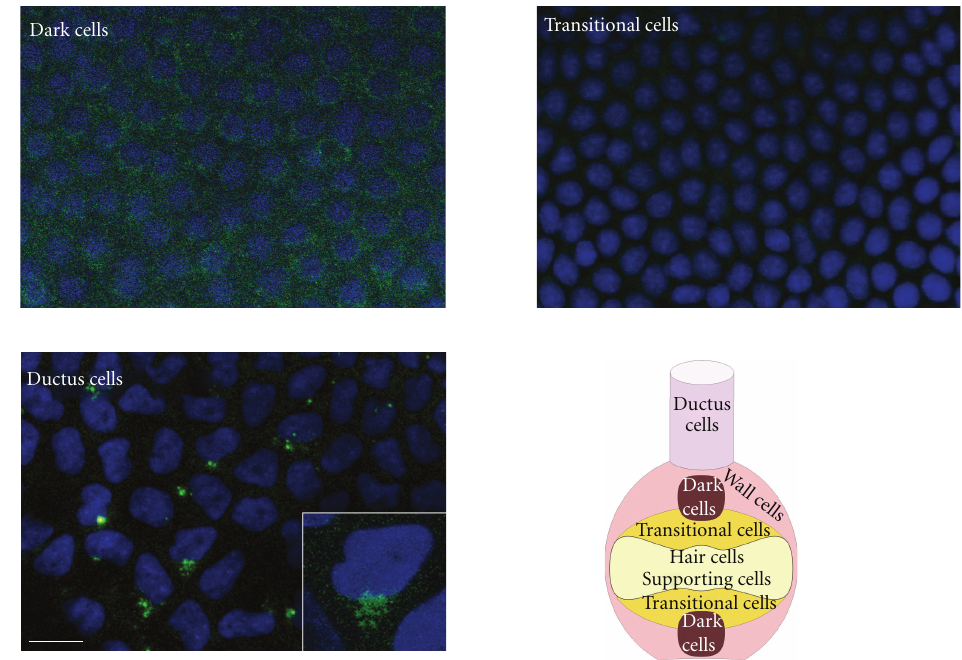
Figure 4: Distribution of ryanodine receptors (RyRs, green) in nonsensory epithelia of the frog canal. Representative immunofluorescence confocal stacks obtained from dark cells, transitional cells, and ductus cells. Both dark cells and ductus cells were positive for RyR, whereas labeling of transitional cells was absent or faint. In ductus cells, RyRs appear localized to a perinuclear formation. Inset shows a single cell at higher magnification. The micrographs are representative of six separate experiments. Bar: 20 μ m. A schematic representation of the distribution of di ff erent epithelial cell types in the semicircular canal is also